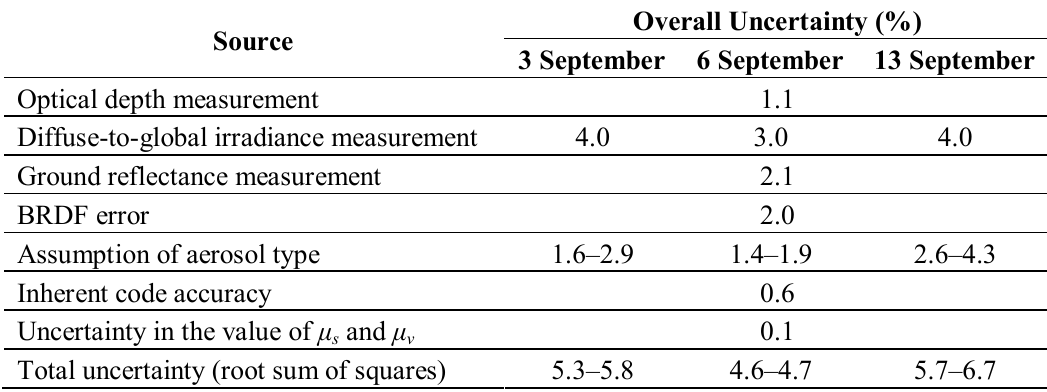
Table 9. Estimated uncertainty in the cross-calibration